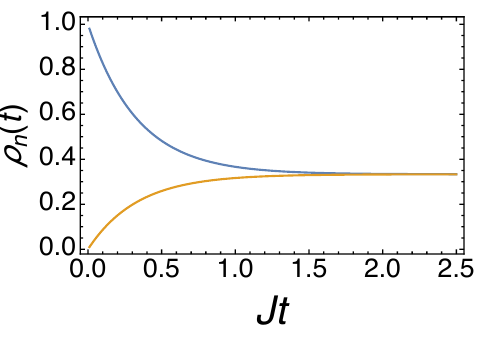
( t ) for the CDW initial state on the sublattice n = 3 k − 2 (blue) Figure 3: Density ρ n and the other two sublattices n = 3 k − 1, n = 3 k (yellow) as functions of time. We observe that the density relaxes quickly to its steady state value 1 / 3.